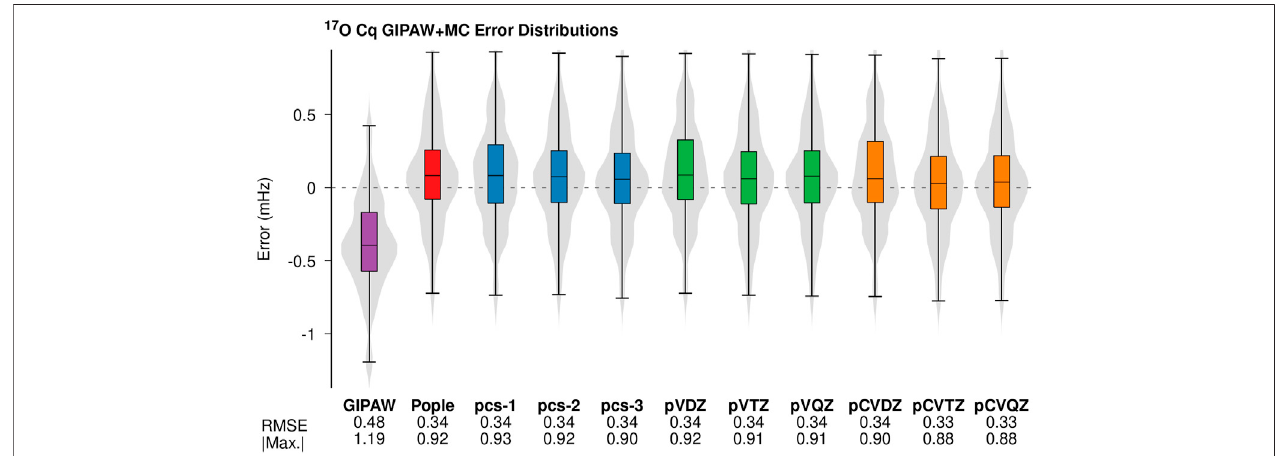
FIGURE 1 | Errors in the 17 O C q predictions from PBE/GIPAW (purple) and GIPAW + MC calculations with PBE0 monomer corrections performed using different Gaussian basis sets. The PBE0/Pople basis (red) corresponds to the data in Table 1 . The violin plots illustrate kernel density estimates for each error distribution. The box-plots within each violin provide the median (black horizontal line), middle two quartiles (colored box), and the whiskers represent the outer quartiles. The corresponding RMS error and maximum absolute errors are provided below each distribution. All values are reported in MHz.